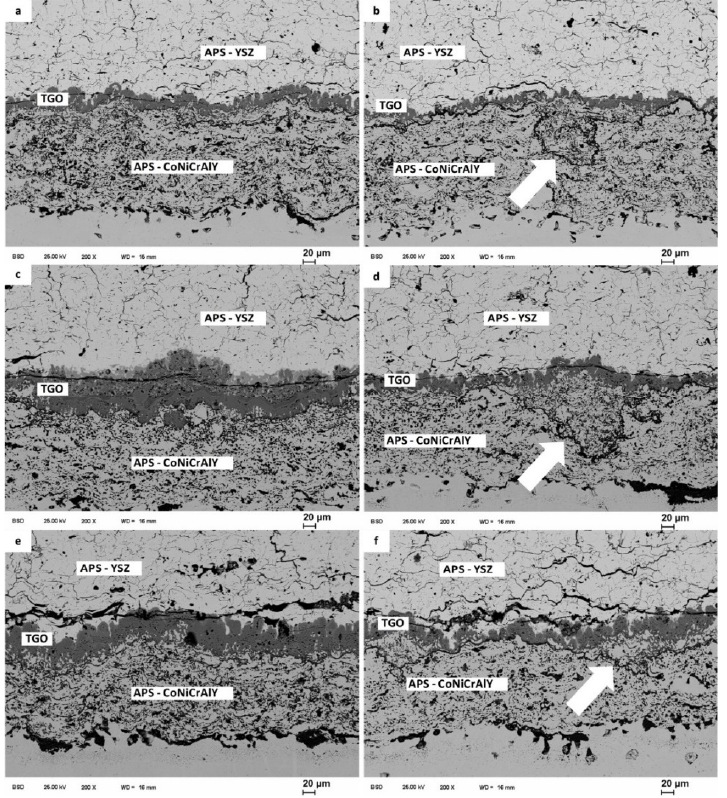
Figure 5. TBC systems after isothermal exposure at 1150 °C: R-TBC (on the left) and Al-TBC (on the right). Dwell time: ( a , b ) 100 h of isothermal exposure; ( c , d ) 300 h of isothermal exposure; and ( e , f ) 600 h of isothermal exposure. The arrows pointing upward mark a dark line rich with “Al” and “O” along the CoNiCrAlY BC microstructures and close to the BC/TC interface on the CoNiCrAlY BC facing side; extended from [22].